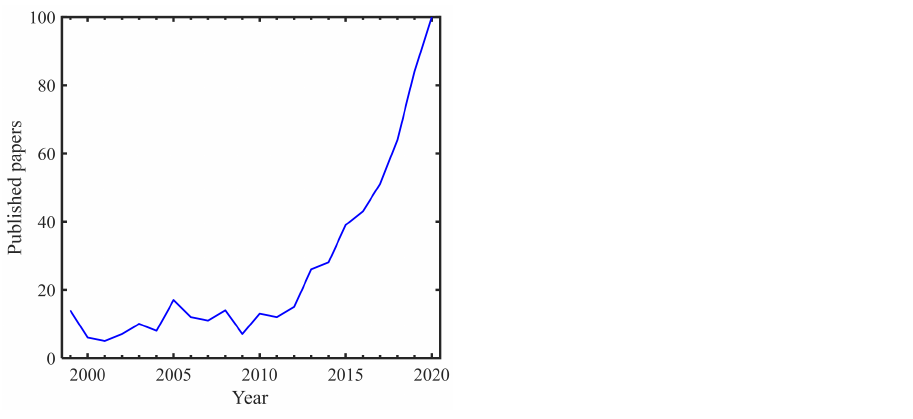
Figure 1. Numbers of published papers searched by “PC shear wall” in Web of Science database [3].